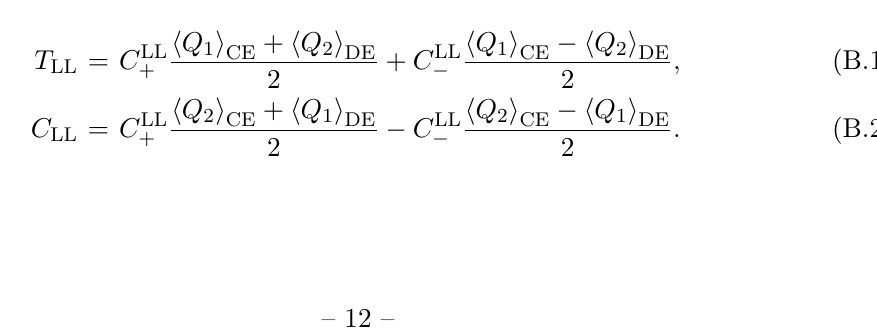
Figure 3 . Correlated prediction for di(cid:11)erence in the CP asymmetry in D + and Re( (cid:15) 0 =(cid:15) ), in the SU(2) L (cid:2) SU(2) R (cid:2) U(1) B (cid:0) L model with charge symmetry. The red, green and blue dots represent the parameter points with randomly generated values of new CP violating phases for M W 0 = 5 TeV, 10 TeV and 50 TeV, respectively. The cyan band stands for the 1 (cid:27) range of the experimental value of Re( (cid:15) 0 =(cid:15) )